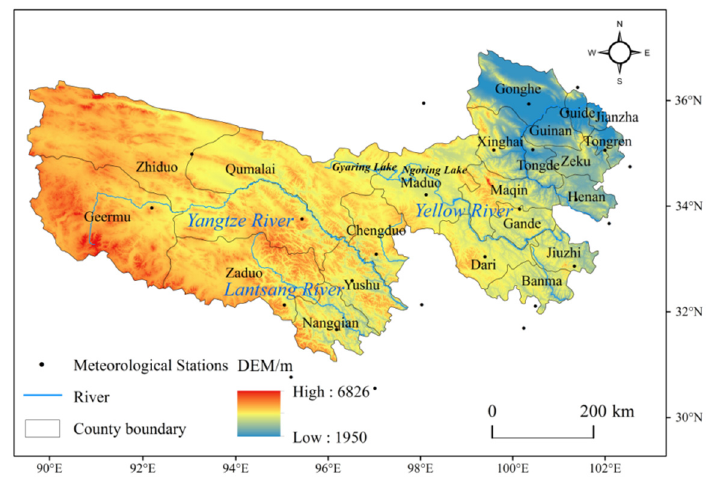
Figure 1. Sketch map of the three-river headwater region.